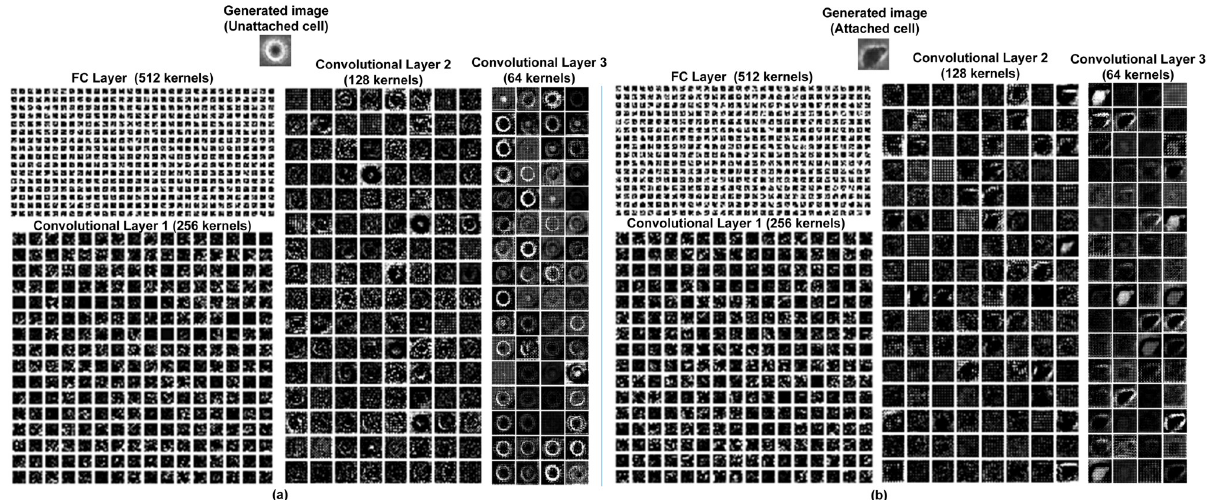
Fig 13. Visualization of features learned by the generators in DeephESC 2.0. (a) Unattached cell and (b) Attached cell .